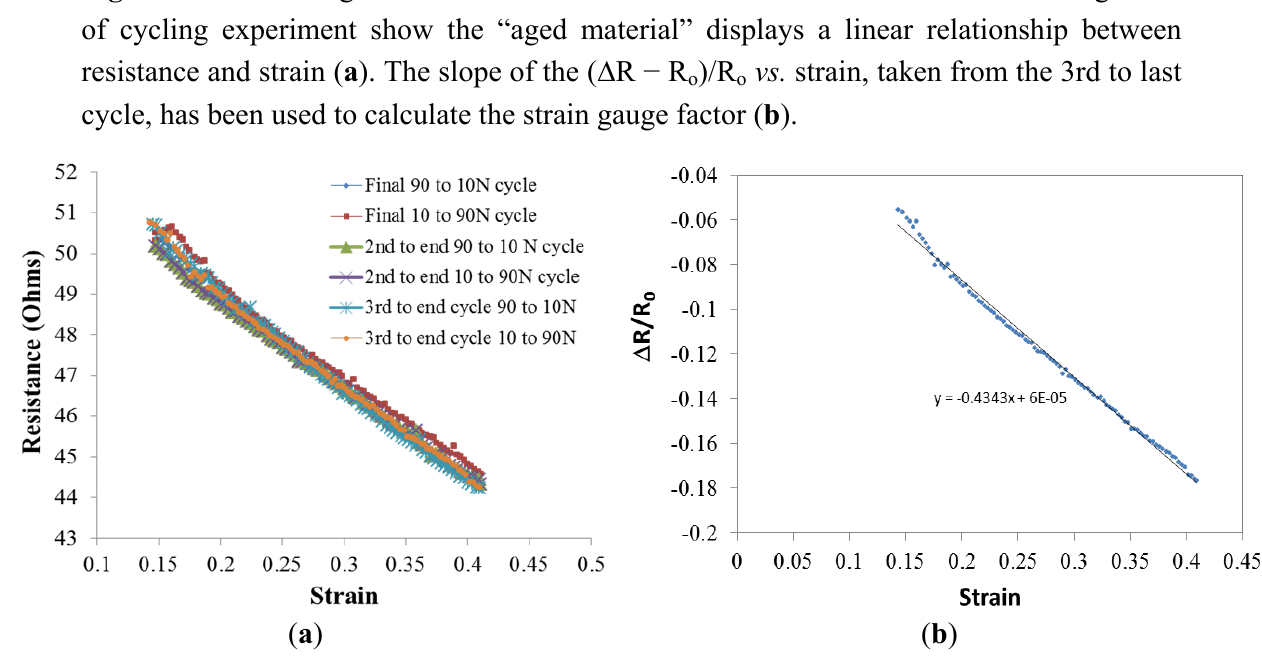
)/R vs. strain, taken from the 3rd to last o o